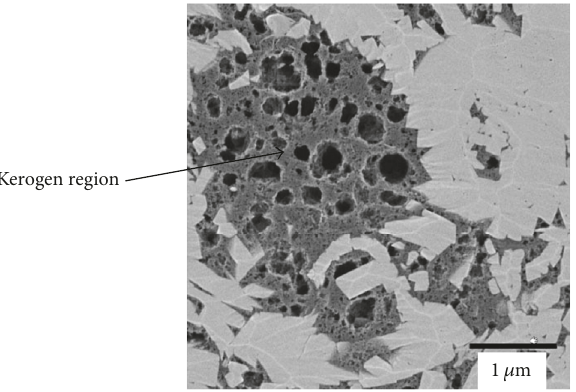
Figure 5: Kerogens in the shale formations are the regions in which most of the gas resources exist (adapted from